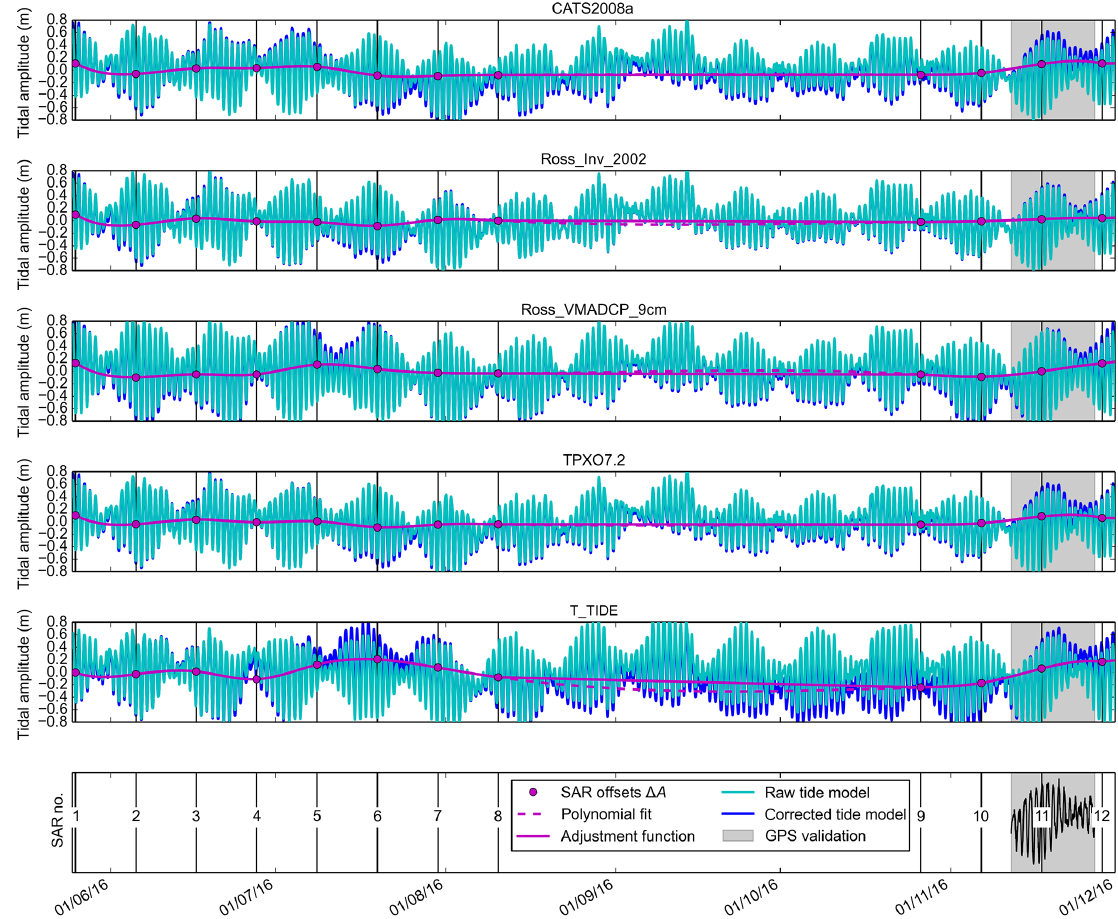
Figure 4. The tidal oscillation at the Darwin Glacier as predicted by four tide models and a harmonic analysis of GPS data from the freely floating area. The tide-model outputs are adjusted to match DInSAR observations using a least-squares fitting technique published by Wild et al. (2018). Black vertical lines coincide with times of SAR data acquisitions. Values for the prevailing tidal amplitudes and their adjustment at these times are given in Table 1. Grey shaded areas delineate the duration of the TIDEx campaign, when GPS data were acquired for validation (Figs. 7 and